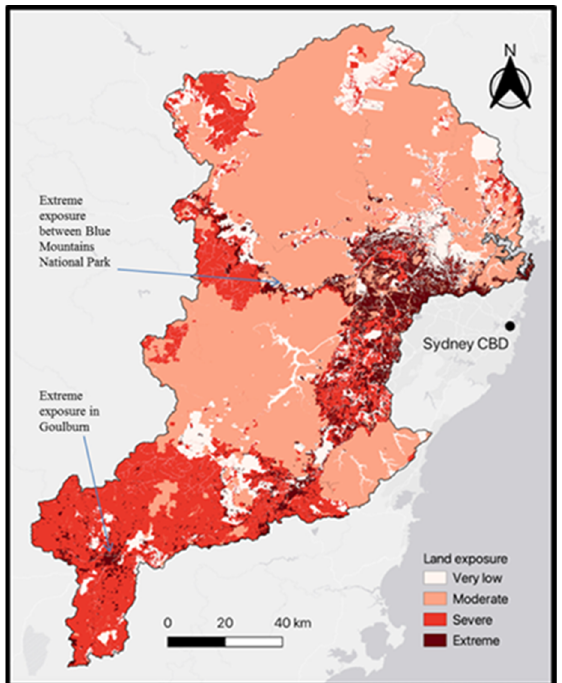
Figure 3. Map of land flood exposure in the HNC using an indicator of land use type (50 m resolution), after fuzzy standardisation (QGIS 3.24).